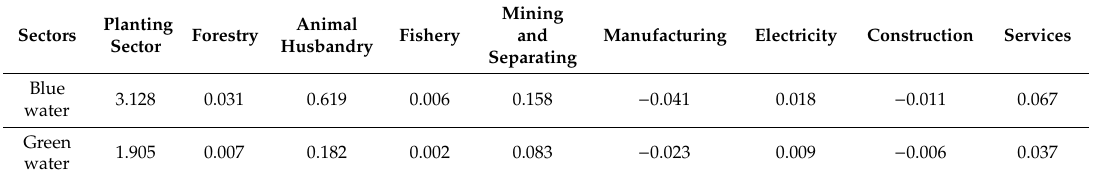
Table 2. Net blue-green virtual water export in NTM with sector details (Unit: km 3 ). Mining Animal Planting Fishery and Manufacturing Electricity Construction Services Forestry Sectors Husbandry Sector Separating Blue 3.128 0.031 0.619 0.006 0.158 − 0.041 water Green water